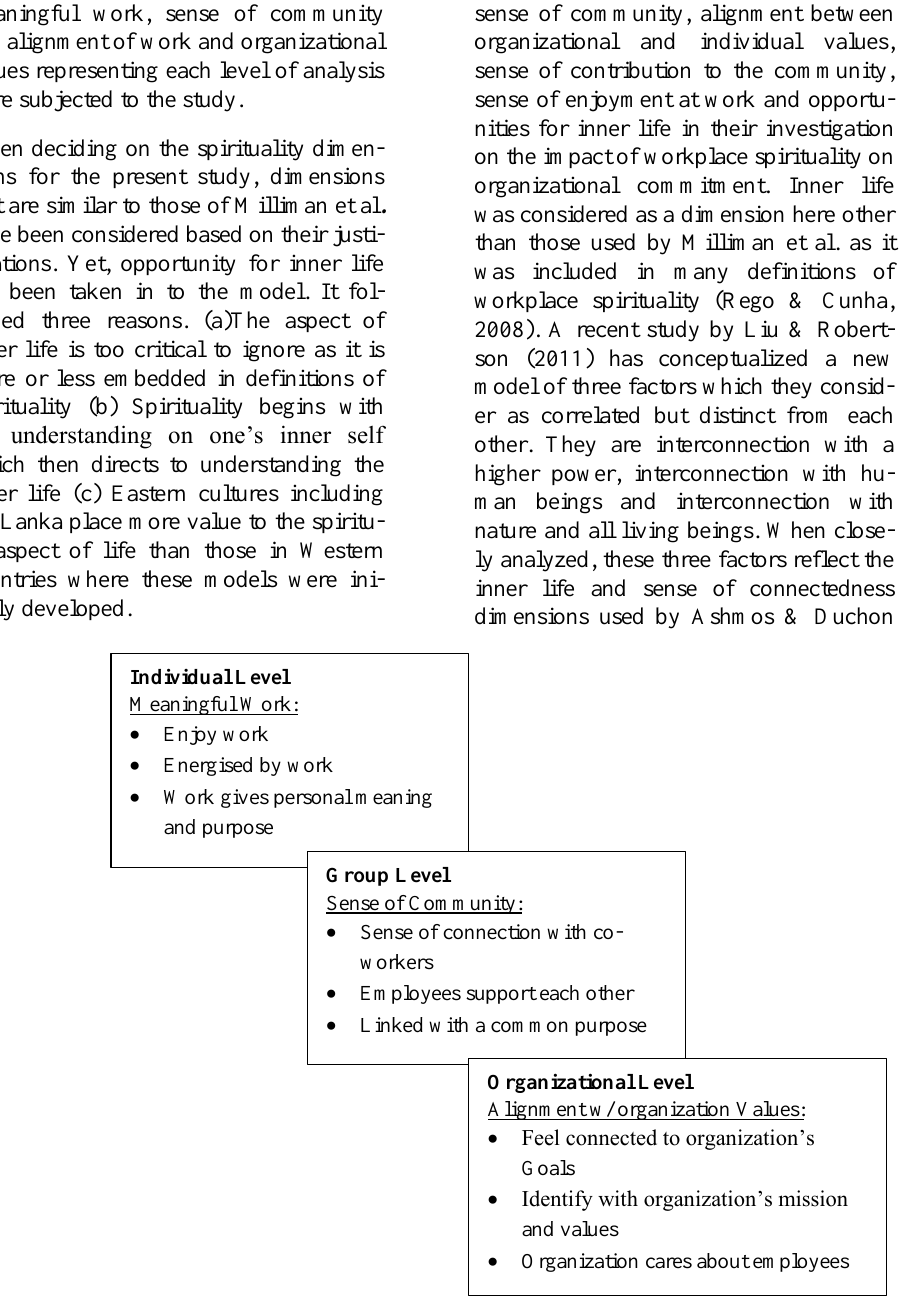
Fig.4 Conceptualizing spirituality in the